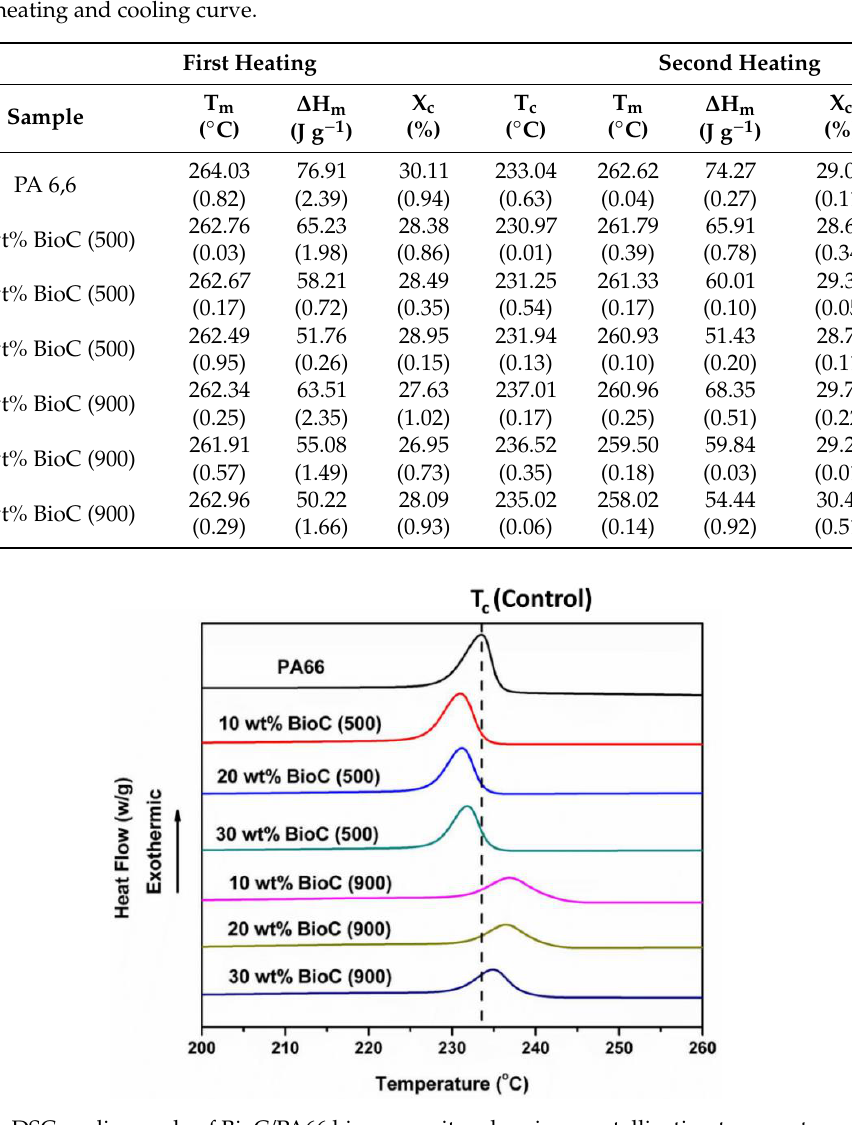
Figure 5. DSC cooling cycle of BioC / PA66 biocomposites showing crystallization temperature peaks.